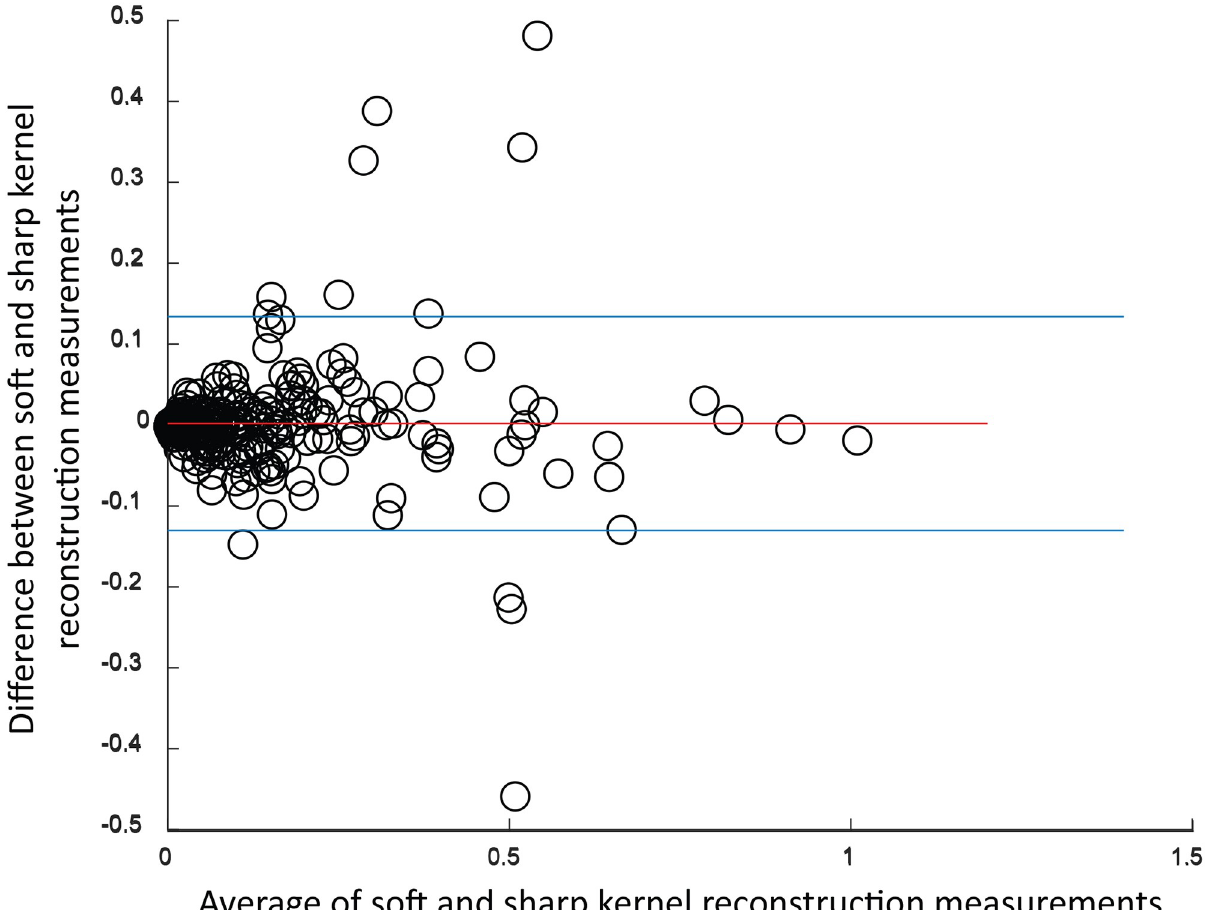
Fig 11. Bland-Altman plot for calcium volume scores calculated with PVC-CS by using soft vs. sharp reconstruction kernels. Bias is 0.002 with limits of agreement [-0.130, 0.134].